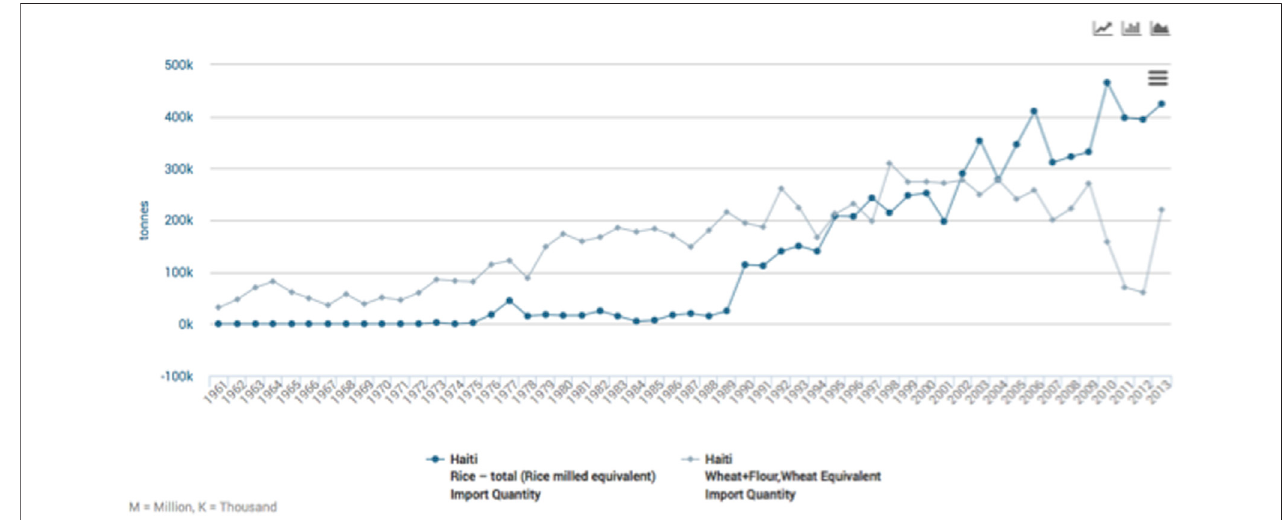
FIGURE 1 | Wheat and rice imports to Haiti 1961 – 2012.